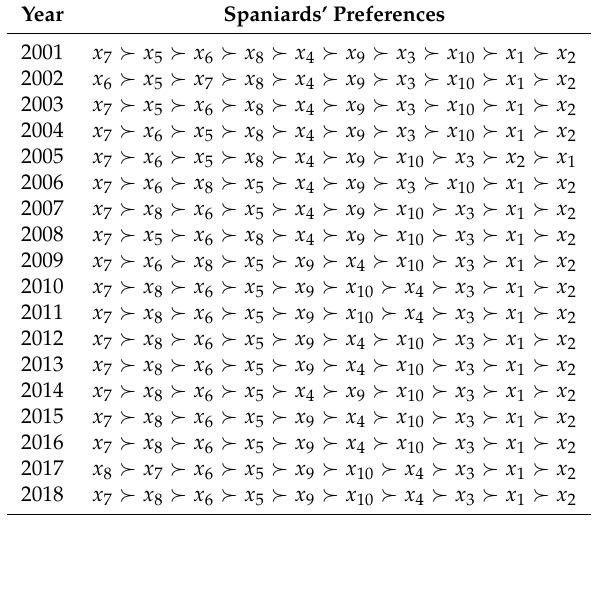
Table A6. Temporal preferences established by Healthcare Spanish Barometer from Question 2.